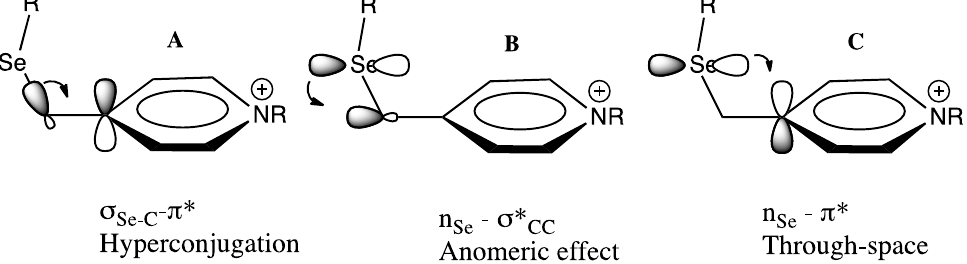
Figure 3. Orbital interactions involving the selenium substituent in 2- and 4-substituted pyridinium